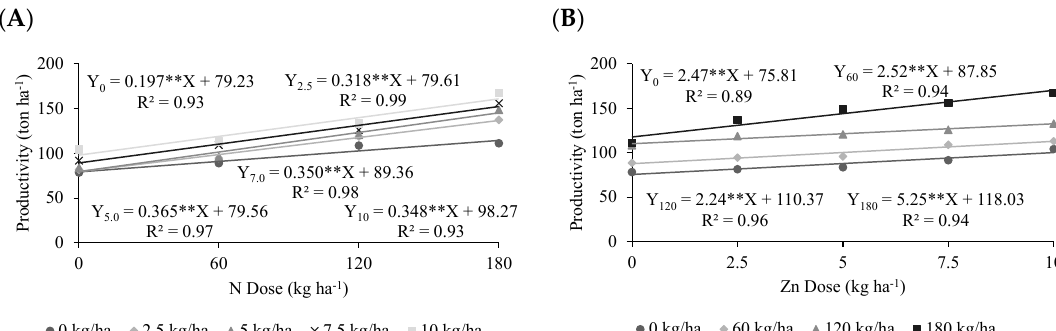
Figure 2. Sugarcane productivity (plant crops) in response to nitrogen ( A ) and zinc ( B ) fertigation doses, under field conditions in Jataí, GO, Brazil. ** significant at p < 0,01 probability according to the F test. Doses of Zn, Y 0 : 0 kg ha − 1 of Zn, Y 2.5 : 2.5 kg ha − 1 of Zn, Y 5.0 : 5.0 kg ha − 1 of Zn, Y 7.5 : 7.5 kg ha − 1 of Zn and Y 10 : 10 kg ha − 1 of Zn ( A ). Doses of N, Y 0 : 0 kg ha − 1 of N, Y 60 : 60 kg ha − 1 of N, Y 120 : 120 kg ha − 1 of N, Y 180 : 180 kg ha − 1 of N ( B ).